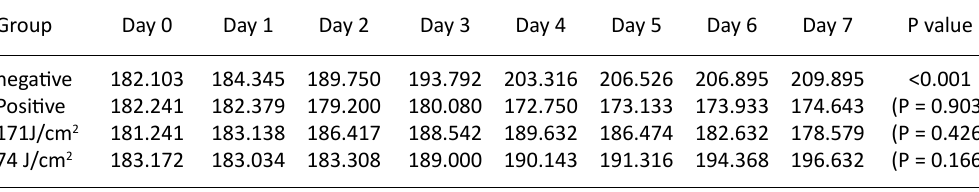
Table 1. Comparison of weight changes